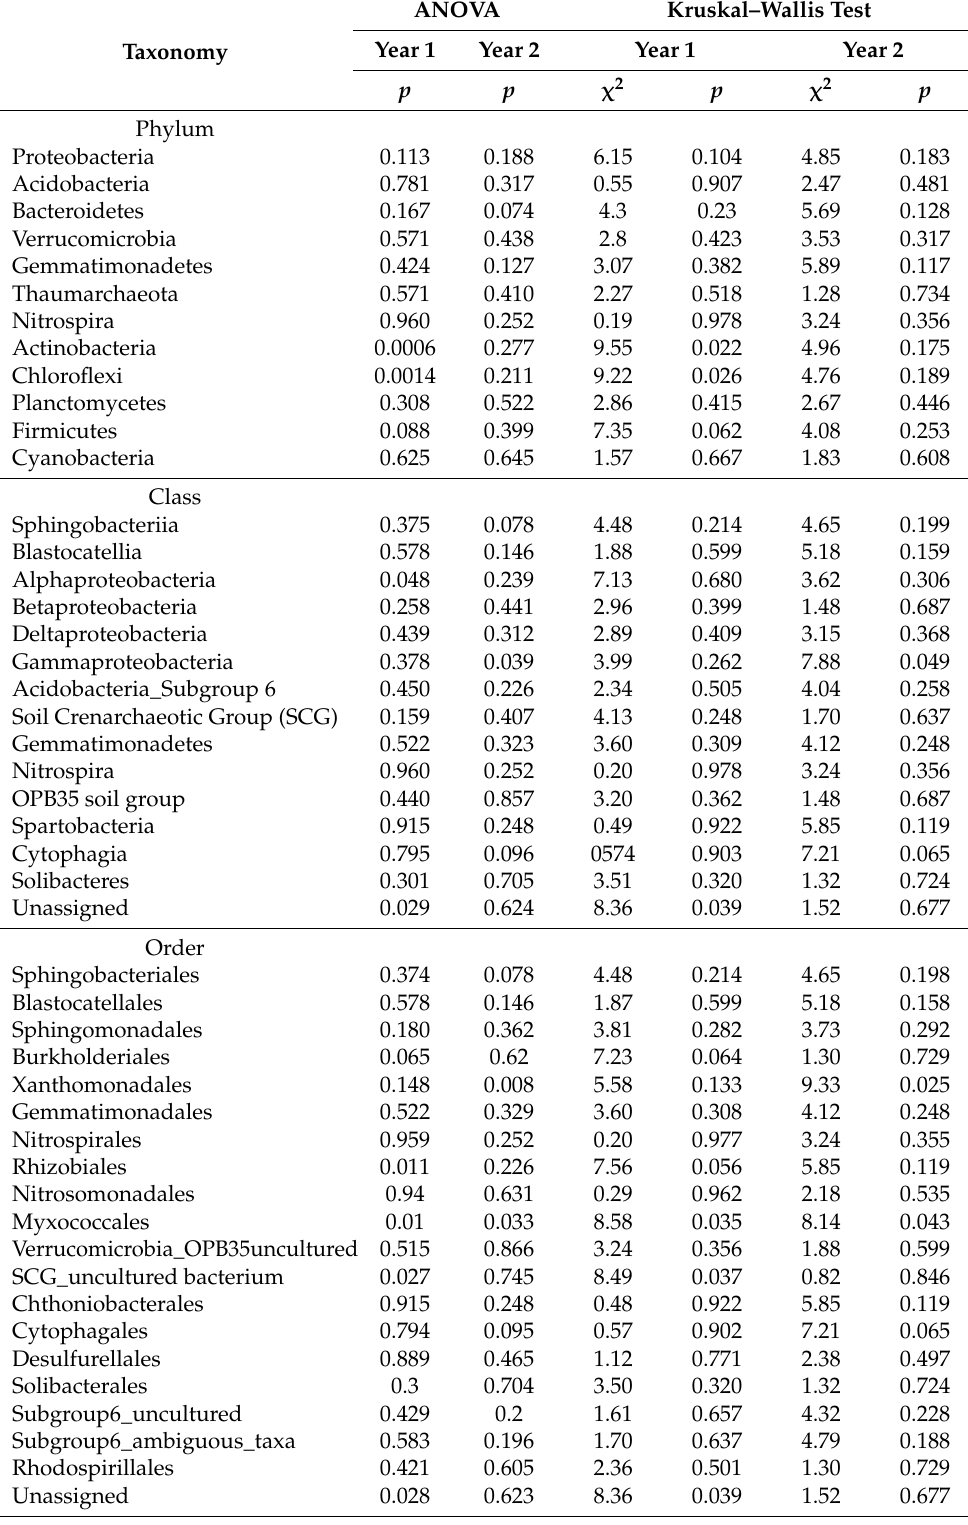
Table 8. Statistical data of one-way ANOVA ( p -values) and Kruskal–Wallis test ( χ 2 and p -values) for the bacterial abundance at the phylum, order, and genus